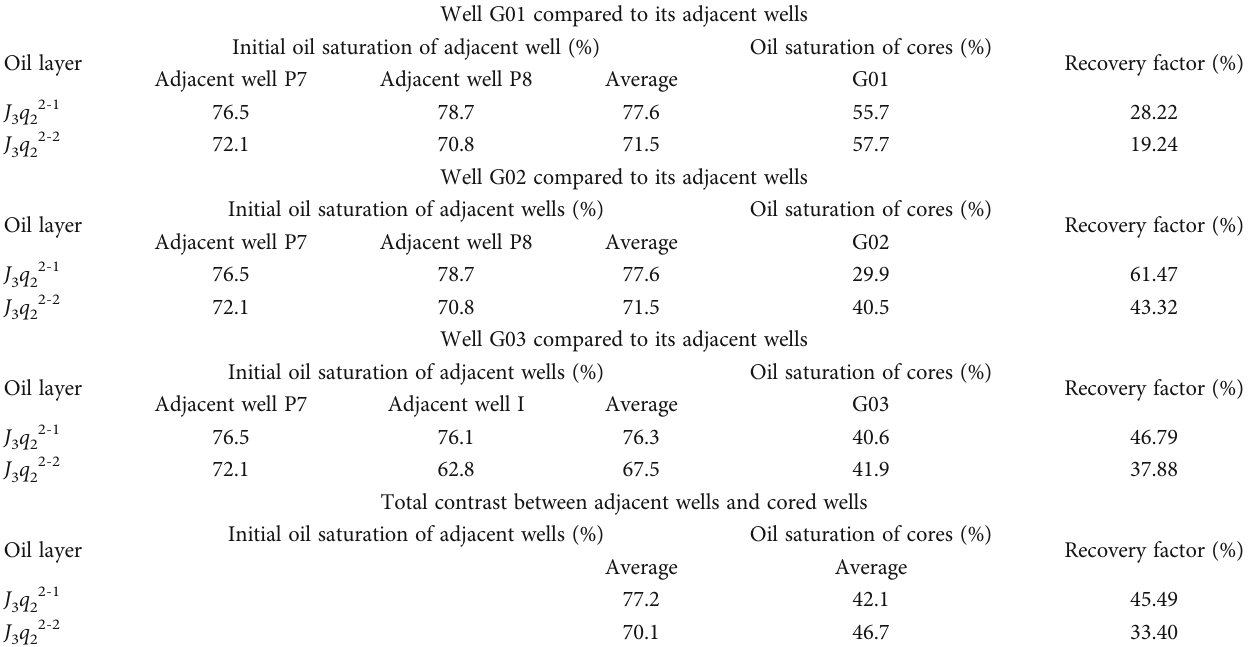
Table 1: Statistical summary based on the information obtained from the cored wells [7, 9]. Well G01 compared to its adjacent